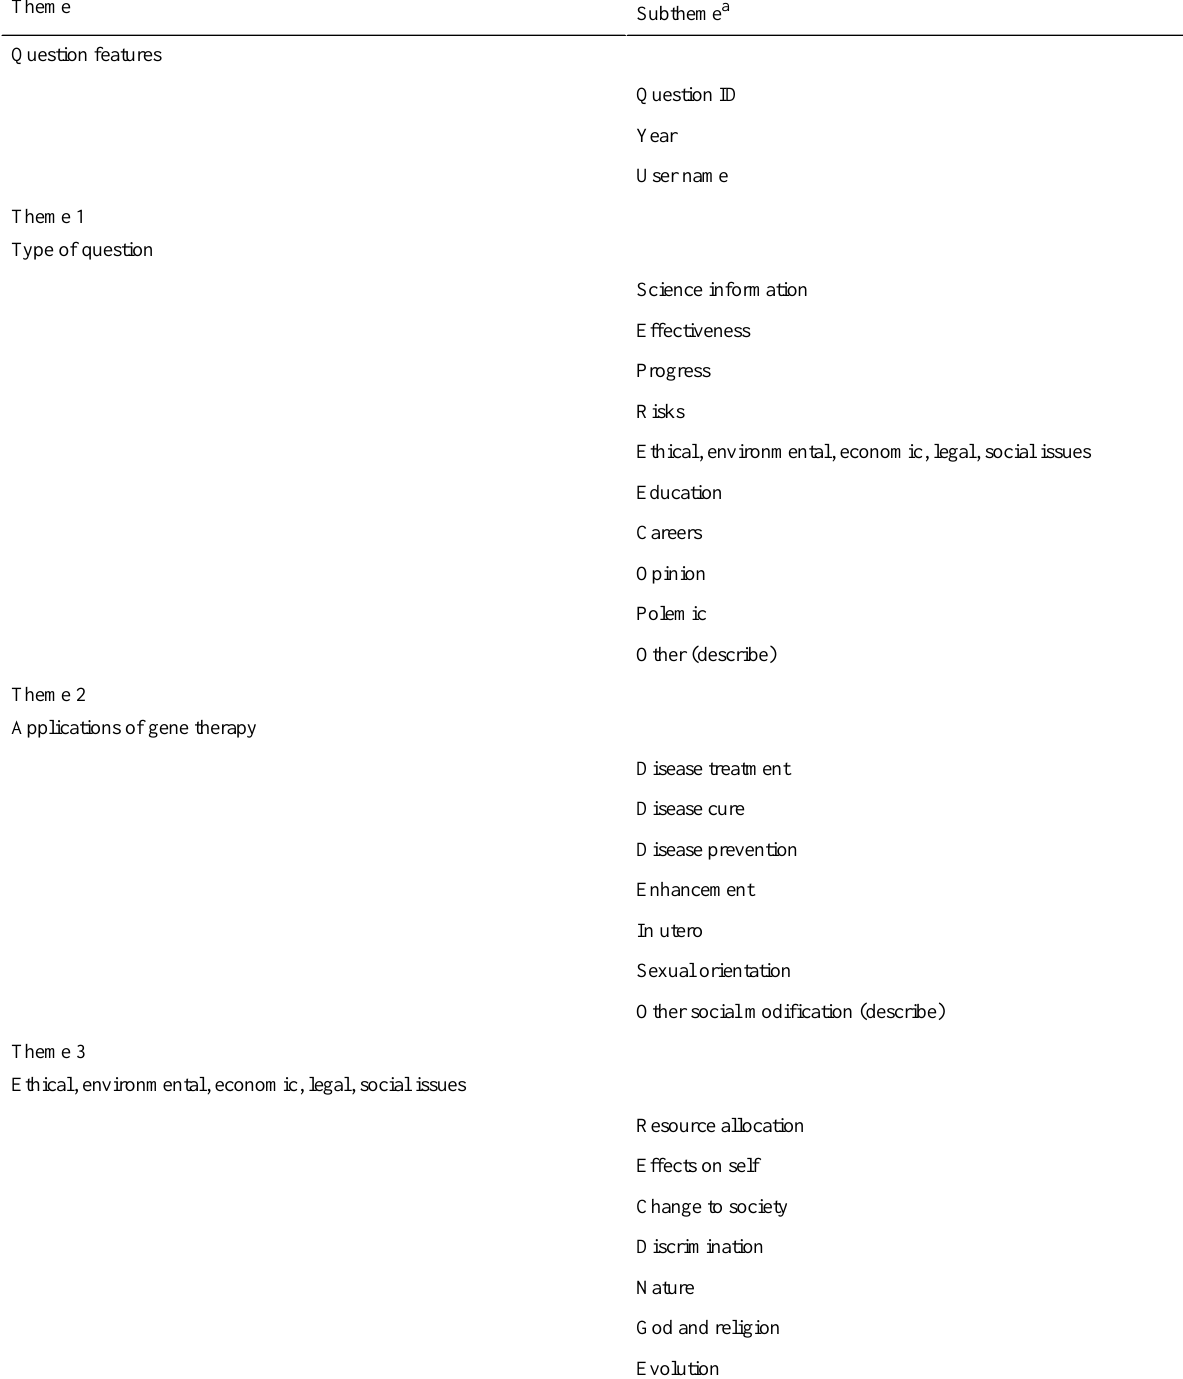
Table 1. Example of coding strategy